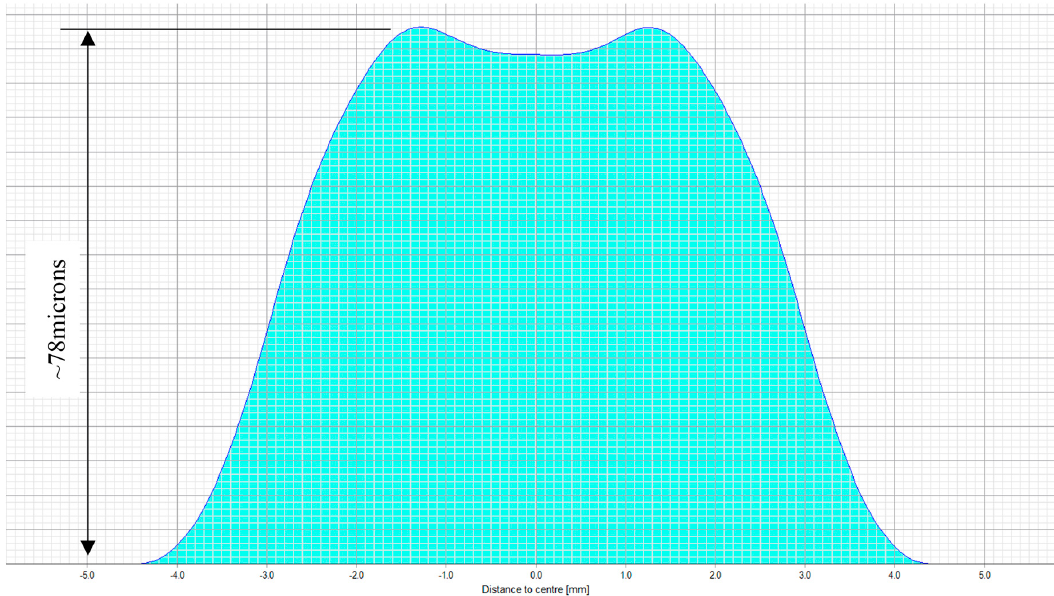
Figure 3. Typical multifocal ablation profile of a combined myopic and presbyopic treatment. The schematic indicates the amount of ablated tissue (blue area), with respect to the distance from the center of the cornea. Such a profile corrects the subjects’ nearsightedness, as well as creates a steep central zone of 3 mm, providing extra refractive power for near-vision.